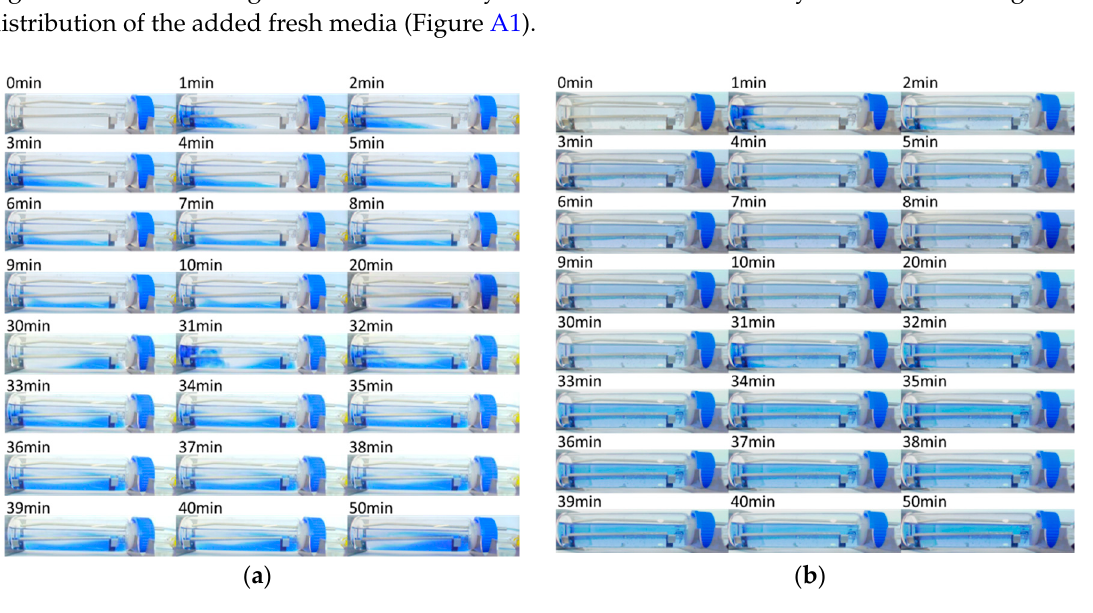
Figure A1. Distribution of Remazol in the flow chamber, injection in the beginning and after 30 min for 6 s (16 mL · h − 1 ). ( a ) Without stirring; ( b ) with a stirrer set to 300